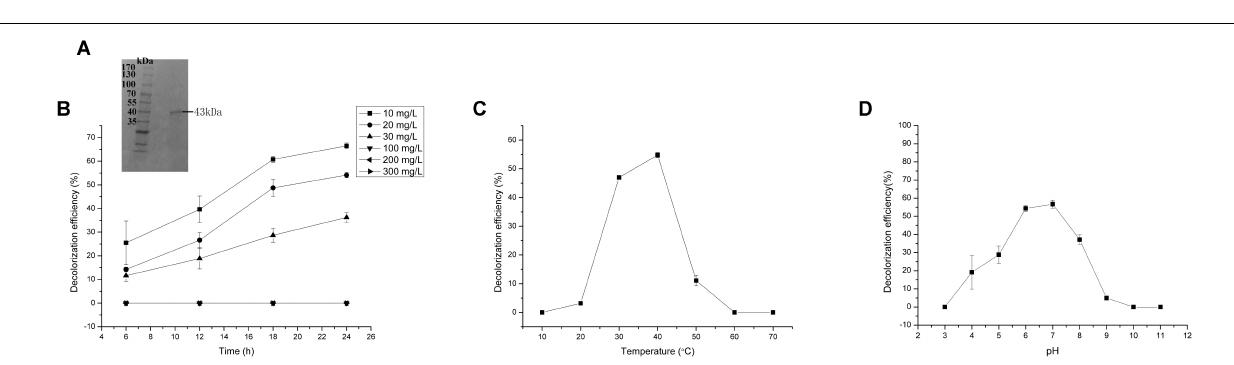
269), 4-(dimethylamino) benzophenone (m/z 226), and 4-(methylamino) benzophenone (m/z 212) ( Figure 7 and Supplementary Figure S2